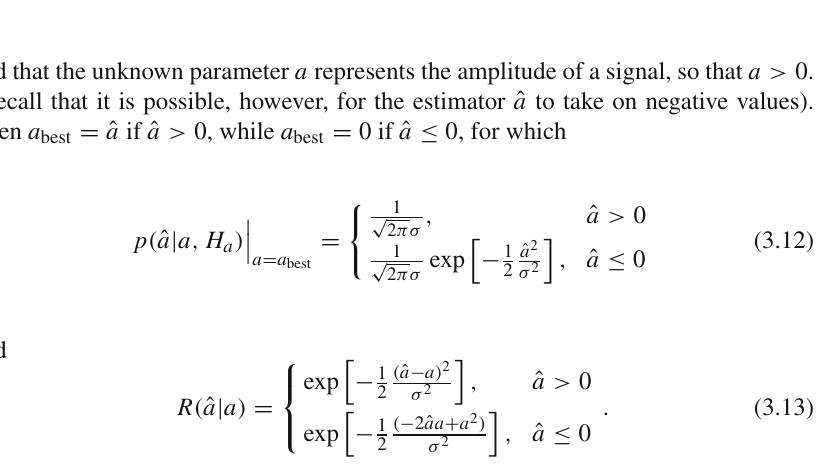
Fig. 7 Confidence belt for 95% confidence-level intervals for a Gaussian distribution with mean a > 0. (The values for a and ˆ a are given here in units of σ ). The solid horizontal line shows the acceptance interval for a = 2 . 0. The two dashed vertical lines correspond to two different observed values for the estimator ˆ a : ˆ a = − 0 . 5, which has a 95% confidence-level upper limit a ≤ 1 . 5; and ˆ a = 2, which has a 95% confidence-level two-sided interval a ∈ [ 0 . 35 , 3 . 95 ]